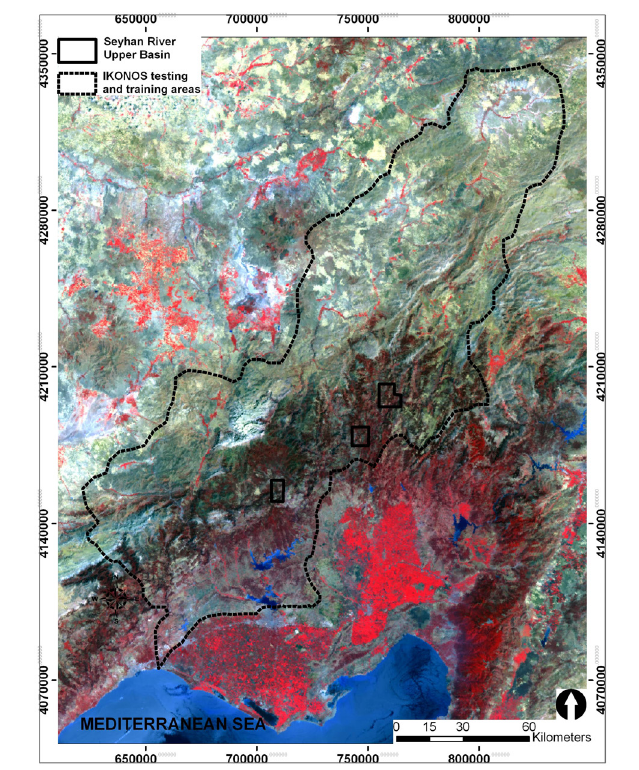
Figure 2. Envisat MERIS image of the study area, and IKONOS training and testing areas.